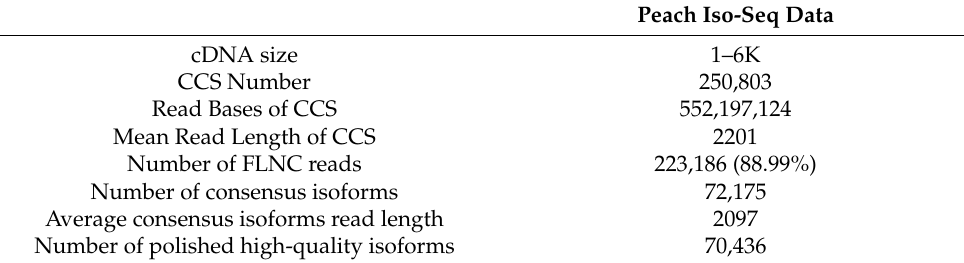
Table 1. Overview of peach Iso-Seq